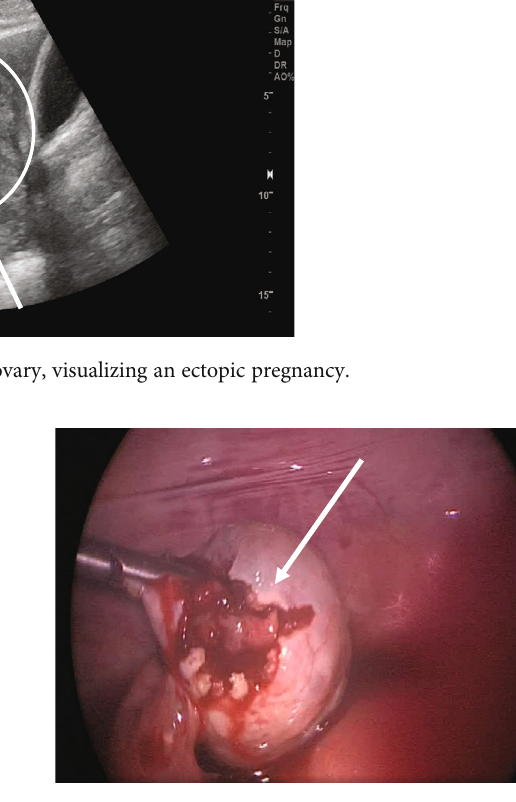
Figure 3: Laparoscopic view of the right ovary showing an ectopic